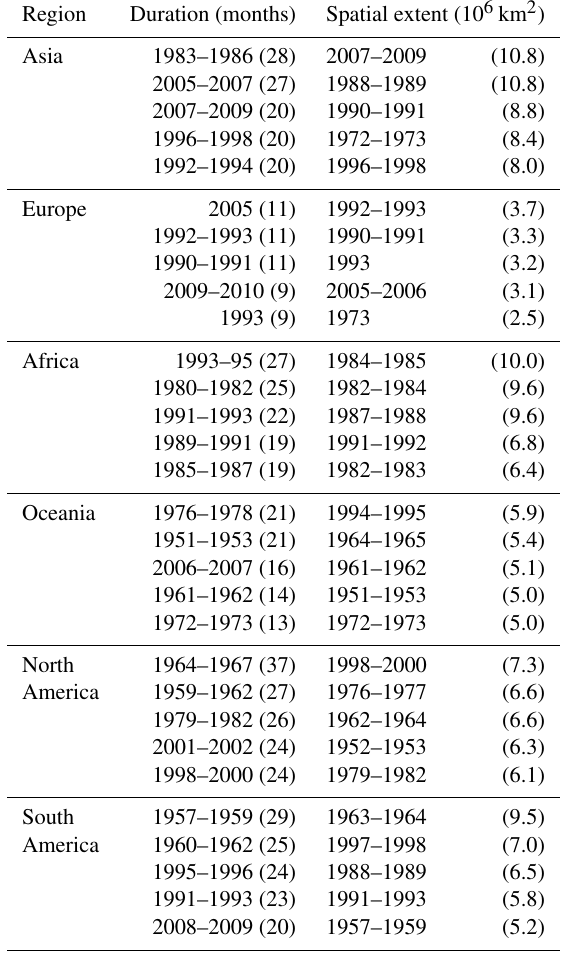
Table 4. Top five drought events in each continent, ranked by dura- tion, or by maximum spatial extent. The duration and spatial extent are listed in parentheses after the period of each drought